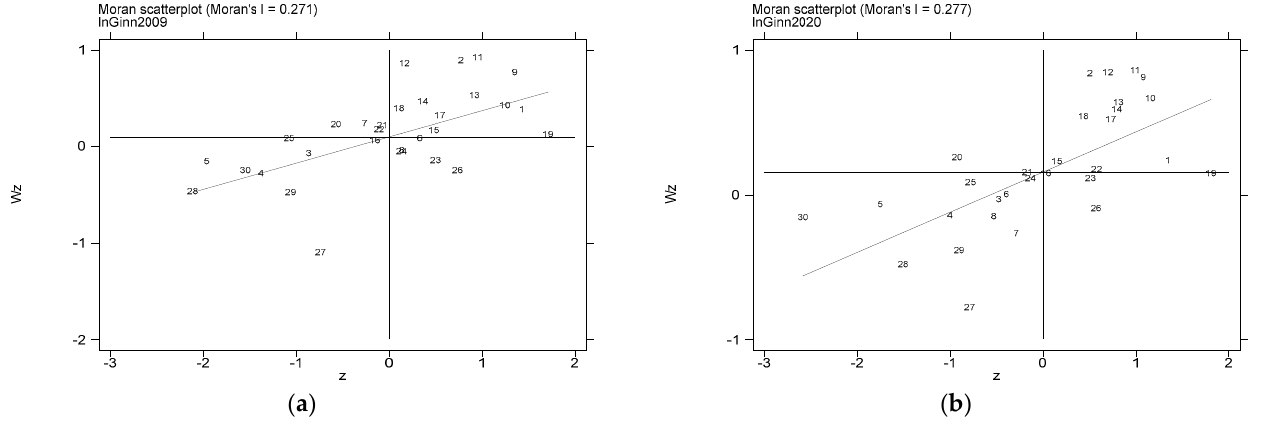
Figure 2. Green technology innovation scatter plot distribution: ( a ) 2009, ( b ) 2020.